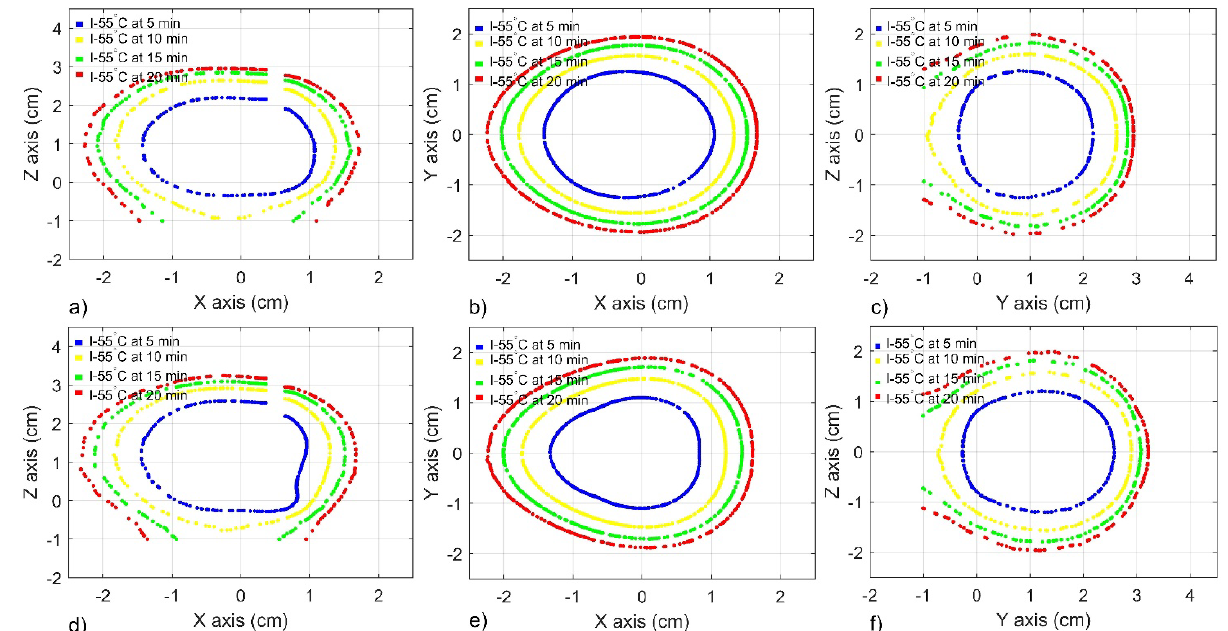
Figure 9. Isotherm contour at 55 °C generated by a triangular antenna array over different planes after 5 min, 10 min, 15 min, and 20 min of treatment time. ( a )–( c ) XZ, XY, and YZ planes for a DS antenna array with ad = 10 mm and bt = 40 mm, respectively ( d )–( f ) XZ, XY, and YZ planes for a MTM antenna array with ad = 10 mm and bt = 40 mm, respectively. Table 6. Best-case scenarios of ablation zone dimensions for 5 min and 10 min (9 W) for the triangular configurations of DS and MTM